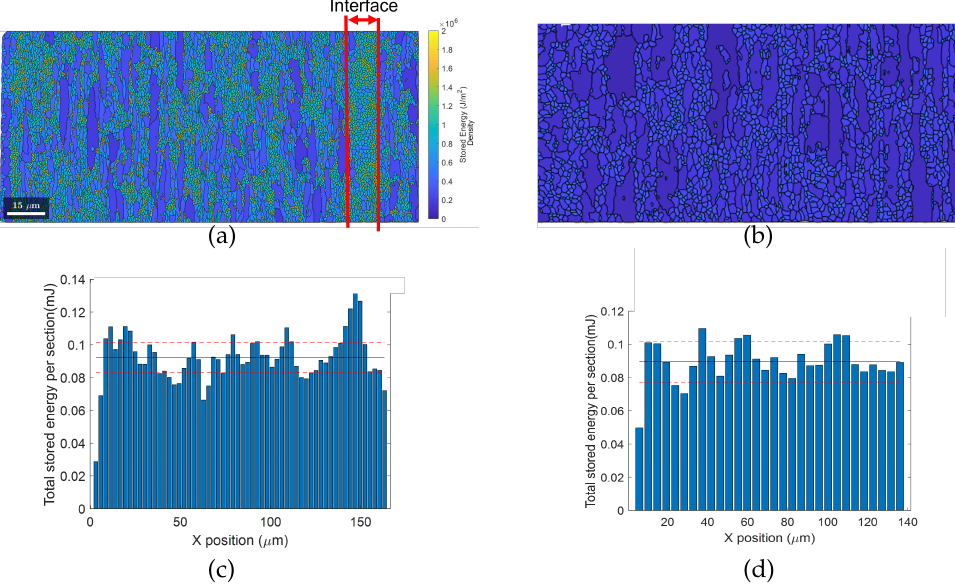
Figure 13. Comparison of post-UAM microstructure vs. foil feedstock microstructure (control): ( a ) stored energy map for sample prepared using 23 µ m weld amplitude; ( b ) stored energy map for the as-received rolled foil (control) showing elongated grains with low misorientations; ( c ) histogram of stored energy showing a peak near the weld interface; ( d ) histogram of stored energy for the